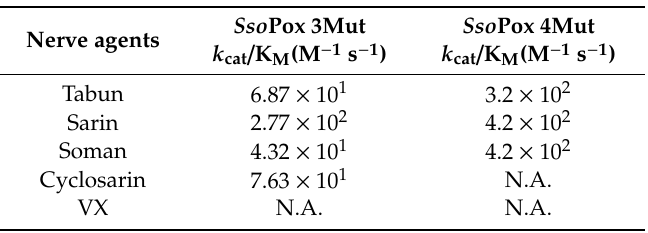
Table 3. Kinetic analysis of Sso Pox3Mut and 4Mut on nerve agents.